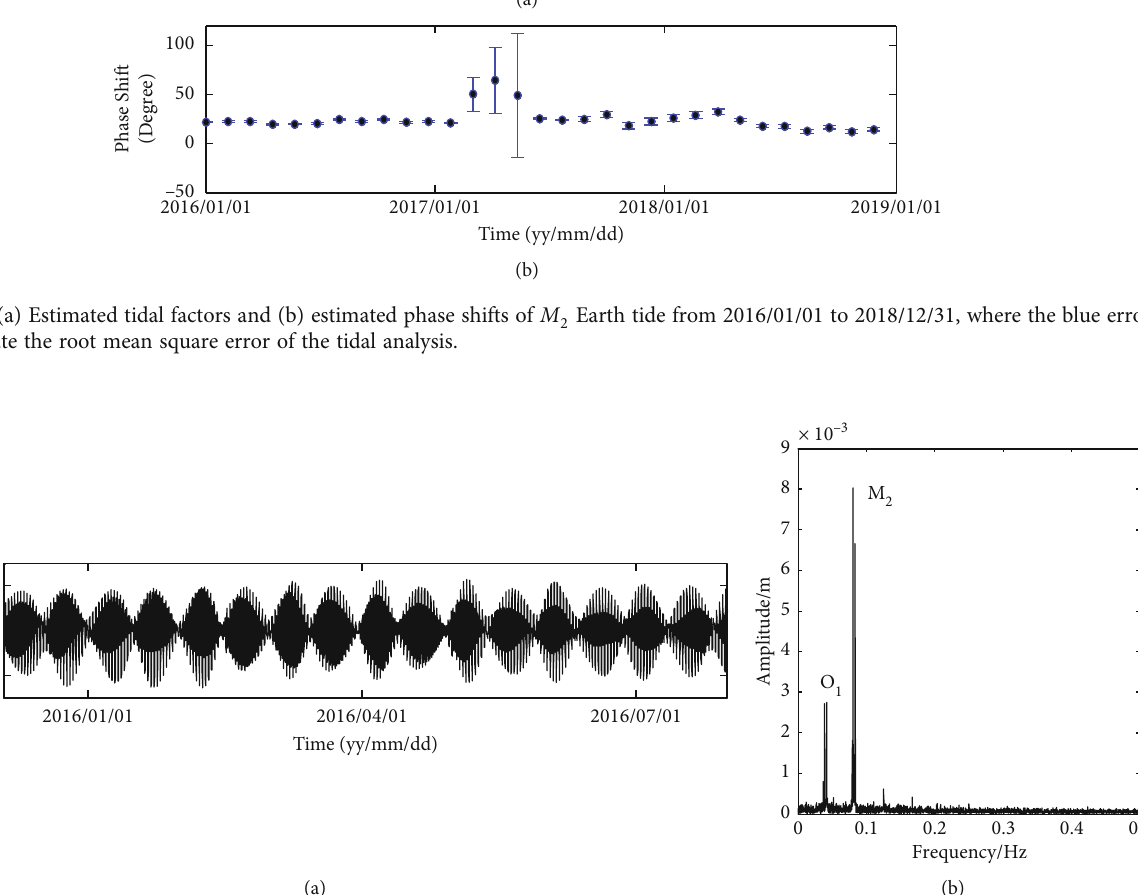
Figure 5: (a) The detrended water level time series showing the response of the water level to Earth tides and (b) normalized fast Fourier transform spectrum analysis of the measured groundwater